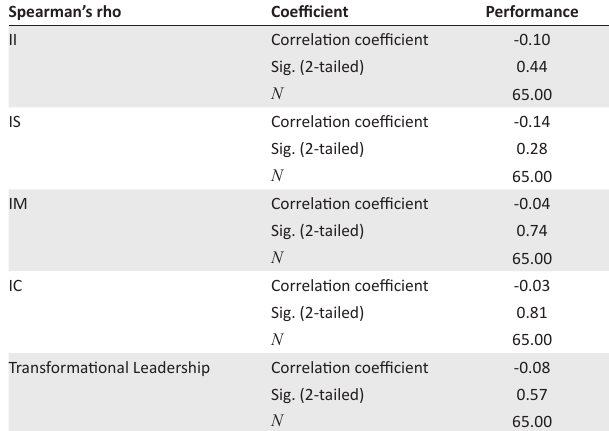
TABLE 11: Correlation analysis between transformational leadership and Individual Job